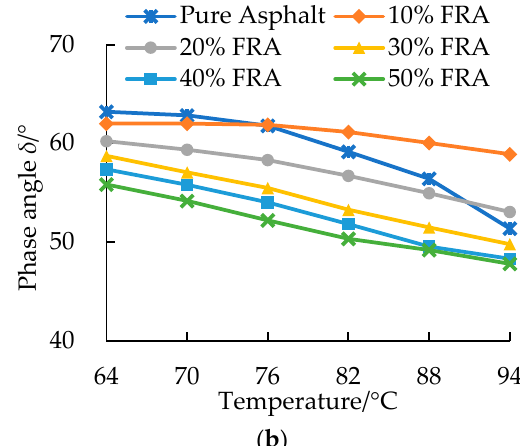
Figure 8. Rheological results and response curves of the pure asphalt binder and FRA: ( a ) complex modulus; ( b ) phase angle.